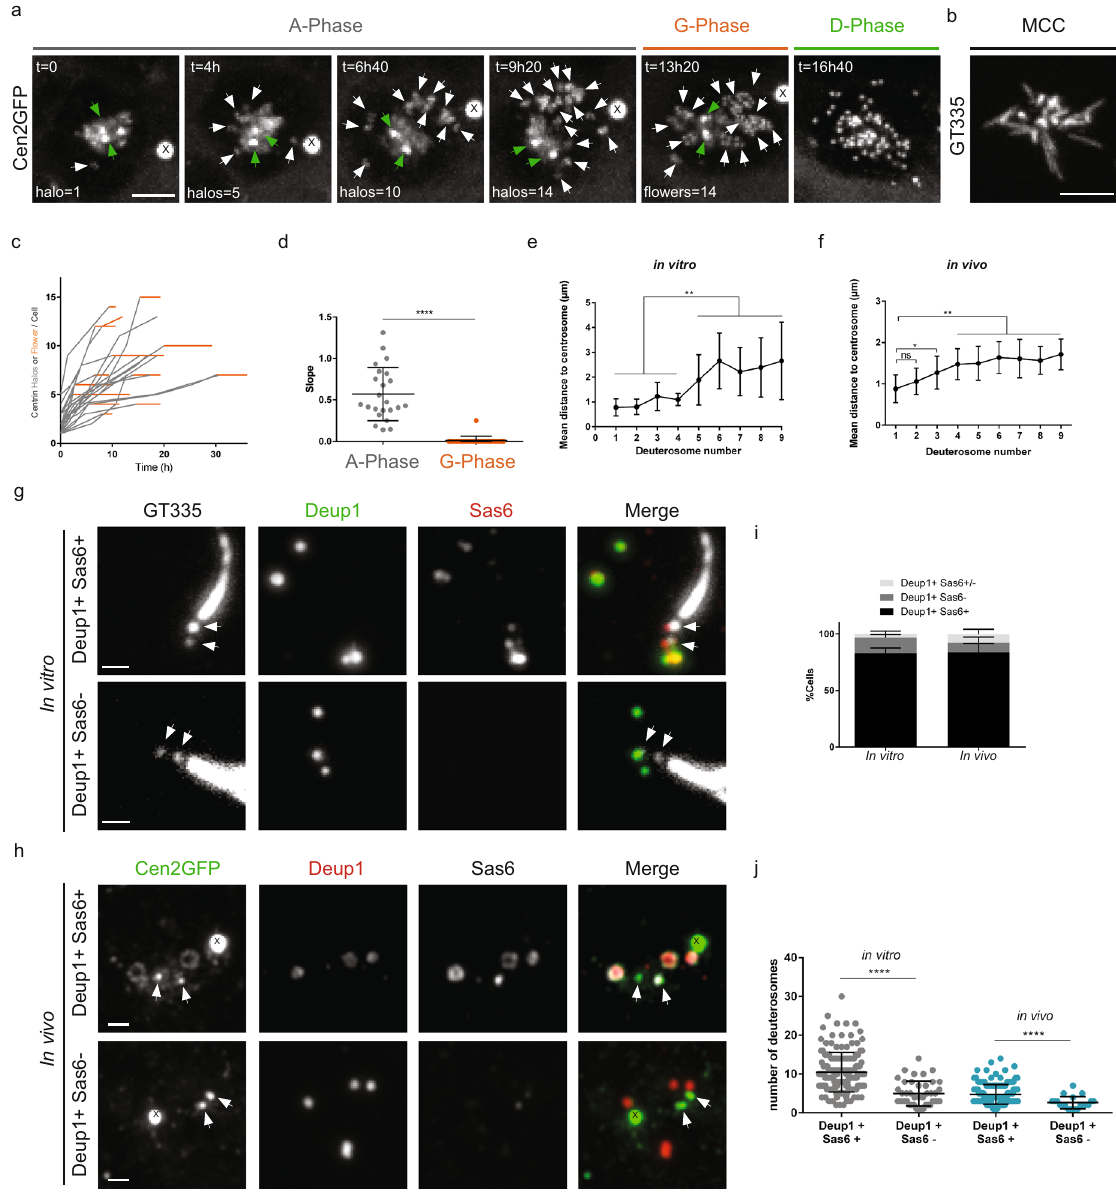
Figure 1. Centriole amplification proceeds sequentially and arises from the centrosomal region. ( a ) Time lapse sequences of a Cen2GFP ependymal progenitor undergoing the different stages (A-Phase, G-Phase and D-Phase) of centriole amplification. Early A-Phase is characterized by Cen2GFP cloud surrounding centrosomal centrioles and the first visible halos in the nearby cytoplasm. As amplification progresses, the number of halos increases and they localize throughout the cytoplasm. In G-Phase, the final number of halos is reached, Cen2GFP halos transform into flowers where procentrioles are becoming visible. In D-Phase, procentrioles individualize. White arrows indicate centrin halos or flowers. Green arrows indicate centrosomal centrioles. ( b ) Cilia immunostaining with GT335 antibody of a Cen2GFP ependymal MCC at the end of a time lapse experiment. ( c ) Number of centrin halos (Gray) or flowers (Orange) during time lapse experiments in Cen2GFP ependymal progenitors ( Δ t = 40 min, n = 23 cells). Halos or flowers are sometimes masked because of their backward movements toward the centrosomal region. Consequently, they have been counted during expansion phases when each single structure is clearly visible by 3D monitoring. ( d ) Trend line slopes corresponding to each cell observed in c in A-Phase and G-phase. ( e , f ) Mean distances of deuterosomes to the centrosome depending on the number of deuterosomes in the cell in vitro ( e , n = 67 cells), and in vivo ( f , n = 134 cells). Deuterosomes were counted when positive for Deup1 and Sas6 stainings. ( g , h ) Immunostaining of cells in A-phase with loaded (Deup1 + / Sas6 + ) or unloaded (Deup1 + /Sas6 − ) deuterosomes, in vitro ( g ), and in vivo ( h ). Arrows indicate centrosomal centrioles. ( i ) Quantification of cells with loaded (Deup1 + /Sas6 + ), partially loaded (Deup1 + /Sas6 + / − ) or unloaded deuterosomes (Deup1 + /Sas6 − ) in vitro (n = 128 cells) and in vivo (n = 279 cells). ( j ) Quantification of the number of deuterosomes depending on the loading status of deuterosomes in vitro and in vivo (n = 196 cells in vitro , n = 165 cells in vivo ). « X » indicates GFP aggregates. Scale bars: ( a , b ) 5 µ m; ( g , h ) 1 µ